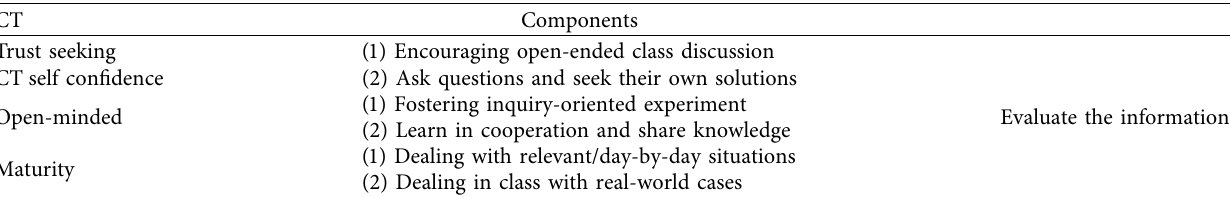
Figure 2: OCIRAC procedure. Table 2: The elements of critical thinking (adopted from Miri et al.